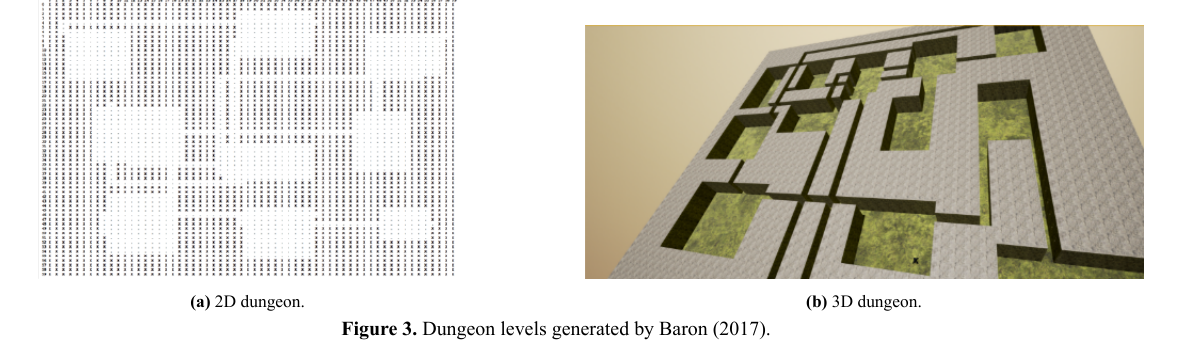
Figure 3. Dungeon levels generated by Baron (2017).